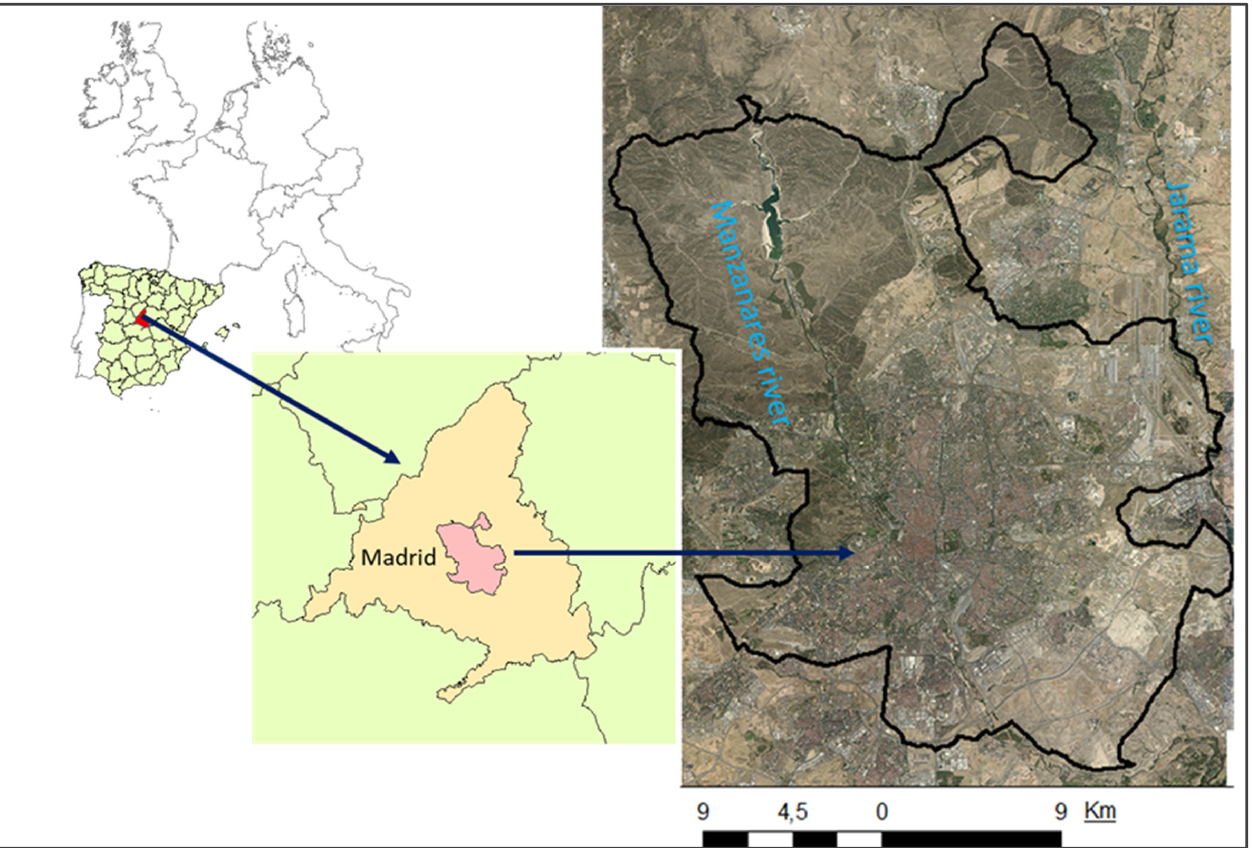
Figure 1. Geographical location of the study area.